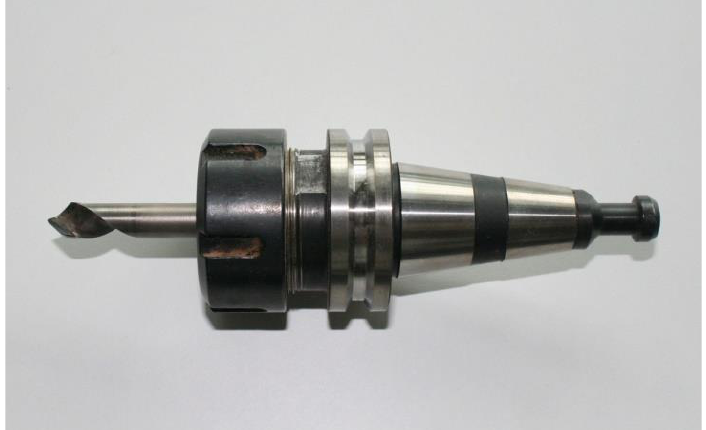
Figure 1. General view of the drill bit (shank part diameter — 10 mm; shank length — 27 mm; total length — 70 mm; number of teeth — 1) with a tool holder (ISO 30, ER 32).